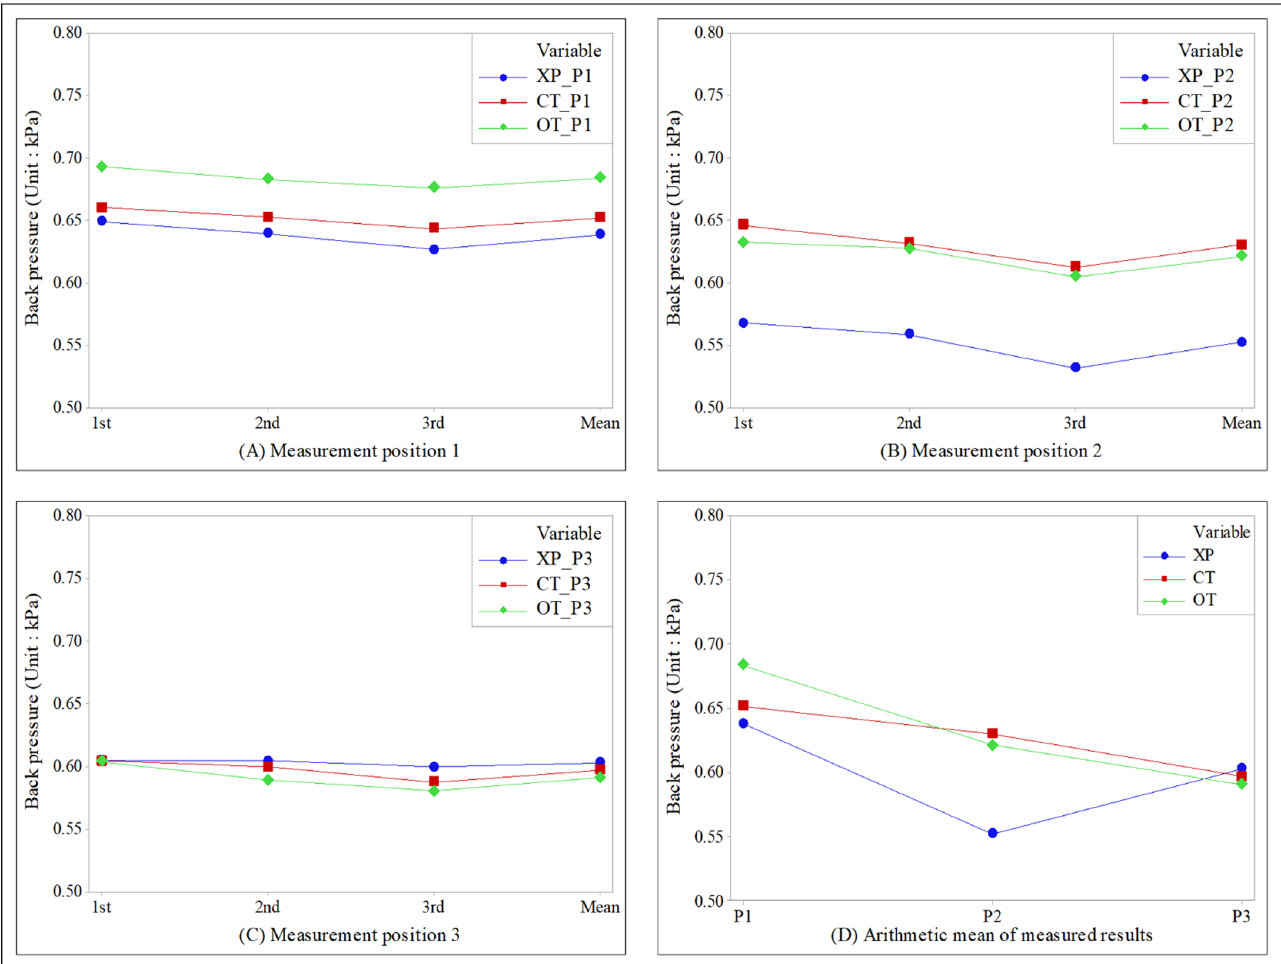
Figure 5. Time-series plot of the back pressure measured at each measurement position ( A ) at measurement position 1; ( B ) at measurement position 2; ( C ) at measurement position 3; ( D ) at each measurement position. XP: X pipe; OT: orifice type; CT: cylinder type.